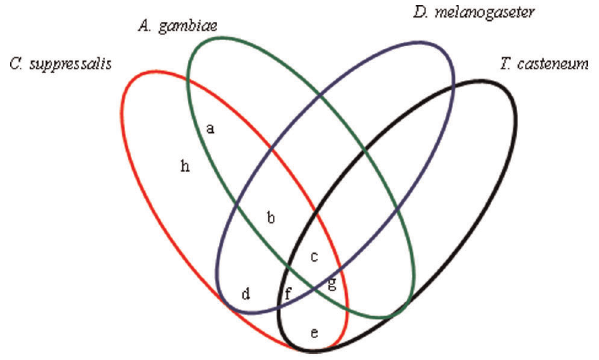
Figure 1. Summary of the comparisons analysis. Chilo suppressa- lis transcriptomic sequences were used to compare with protein sequences from the draft genomes of Anopheles gambiae , Drosophila melanogaster , and Tribolium casteneum . a=228; b=e; c=11419; d=138; e=1564; f=435; g=550; h=22320.